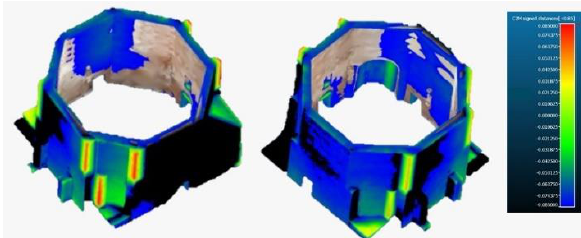
Figure 13. Results of the comparison between three-dimensional models: southwest view (left) and northeast view (right) Min. dist. Table 3. Statistical values (m) of the overlap between the models